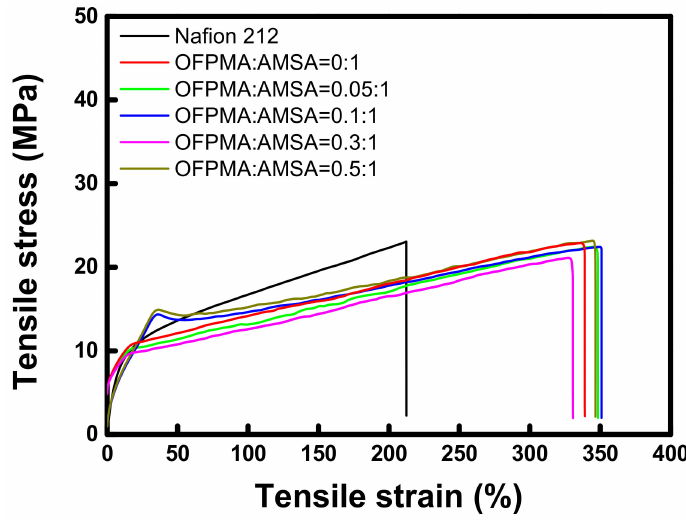
Figure 5. Tensile stress-strain curves of commercial membrane and prepared PFPEMs.